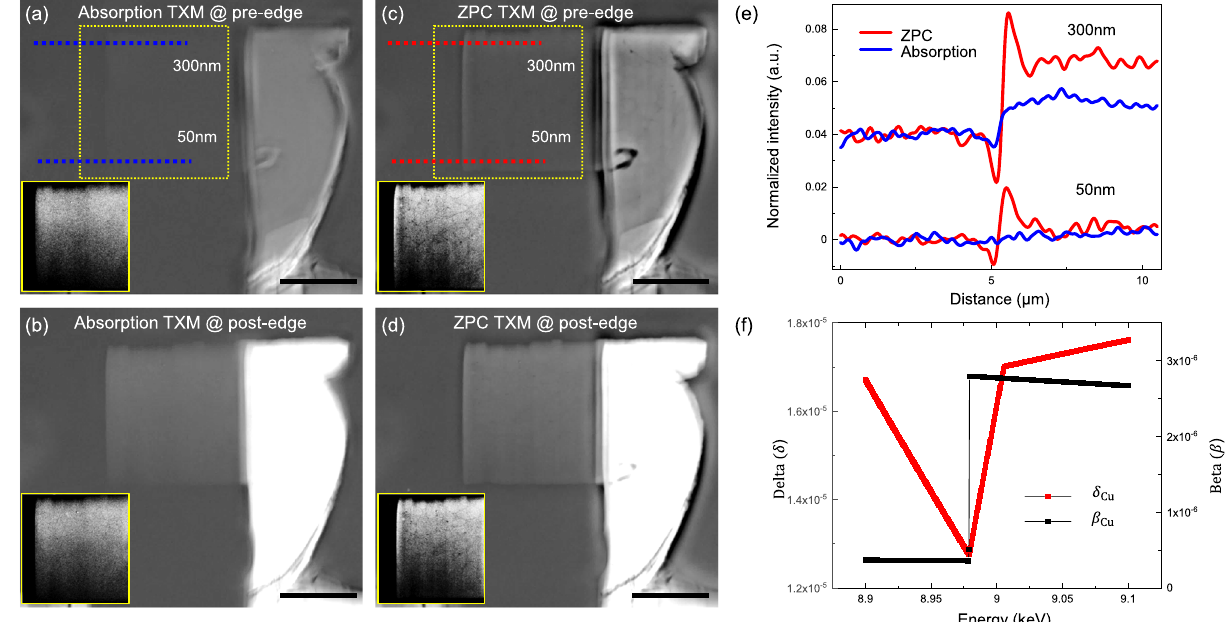
Figure 2. Contrast comparison between absorption and ZPC TXM. ( a , b ) Absorption images of the Cu sample from the selected images at pre-edge (8.960 keV) and post-edge (9.060 keV), respectively. ( c , d ) phase contrast images of the Cu sample from the selected images at pre-edge (8.960 keV) and post-edge (9.060 keV), respectively. Thin wedge Cu is clearly distinguishable in [( c , d ) insets] from [( a , b ) insets]. ( e ) Line profiles of dotted lines at ( a ) and ( c ), where the thickness of Cu were 300 nm and 50 nm. ( f ) X-ray refractive indices of Cu 100 nm at our scan window. The scale bars are 5